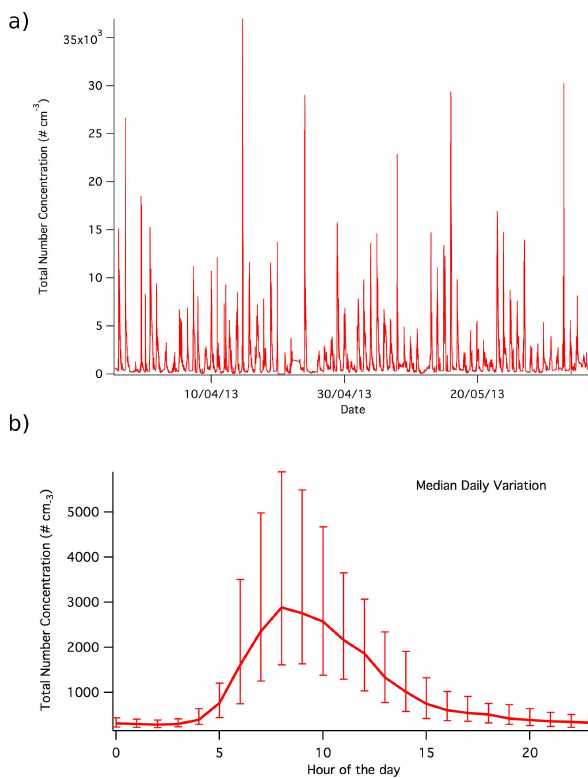
Fig. 8. First aerosol total number concentration observed at Maïdo facility: (a) 2 months time series (April and May 2013). (b) Median daily variation averaged over the whole measurement